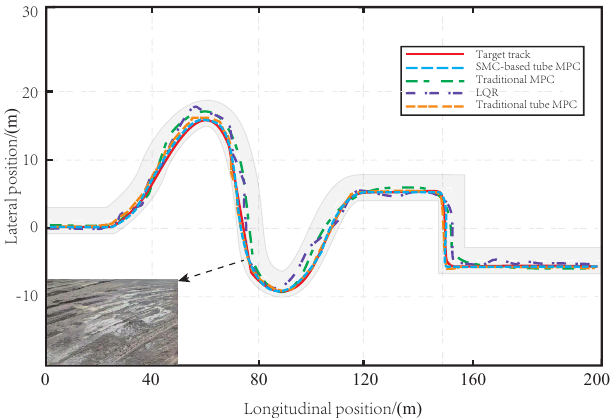
Figure 4. The path tracking effect on the muddy road.